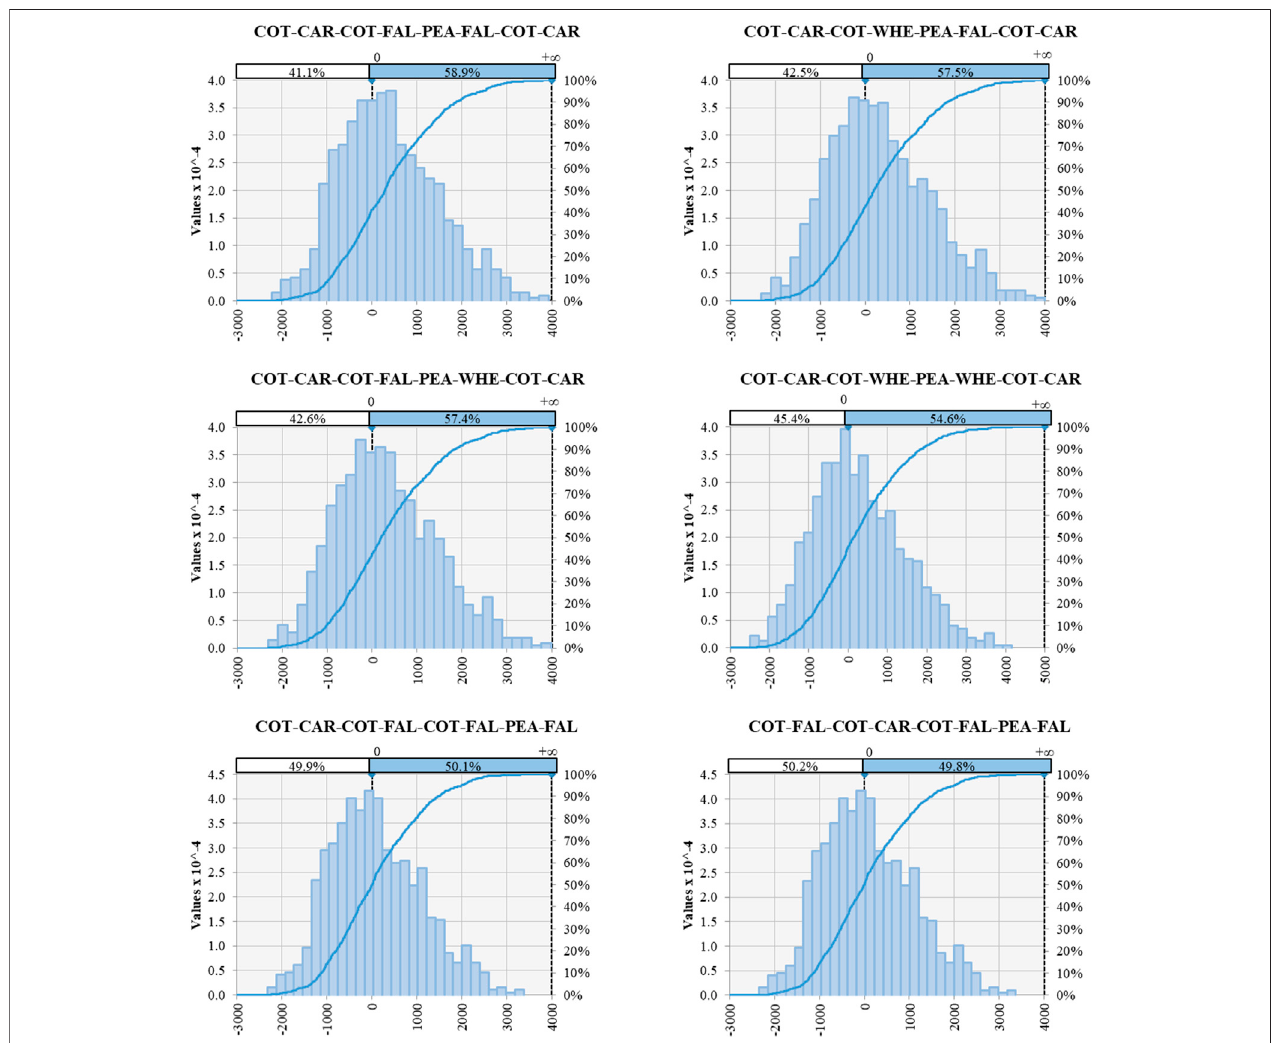
FIGURE 7 | Relative distribution and cumulative frequency of top-six rotations under S3 with the highest chance of positive NPVs.